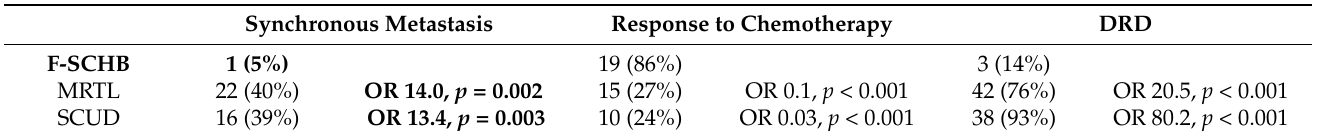
Table 2. F-SCHB vs.